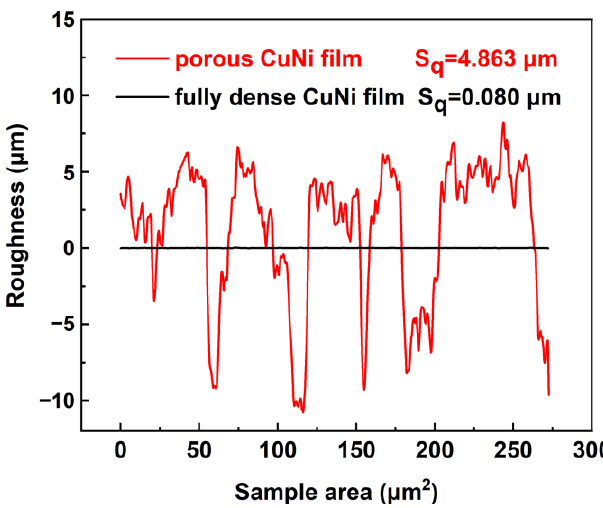
Figure 4. Roughness of porous and fully dense CuNi films.